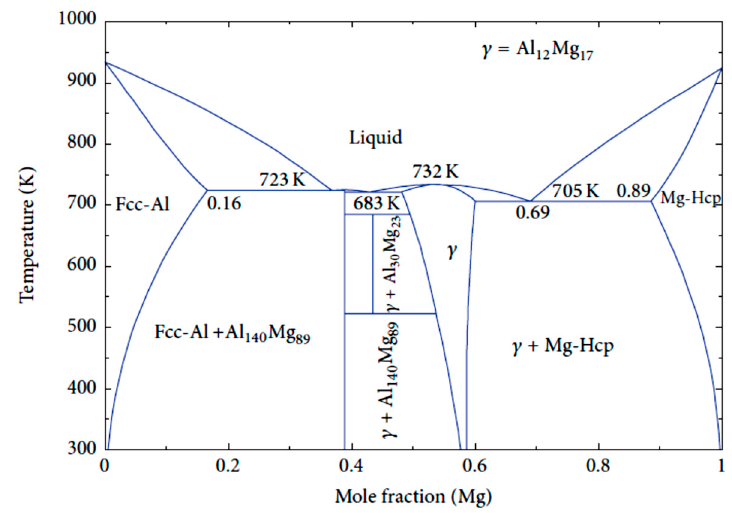
Figure 24. Mg-Al phase diagram. Reprinted with permission from [135].